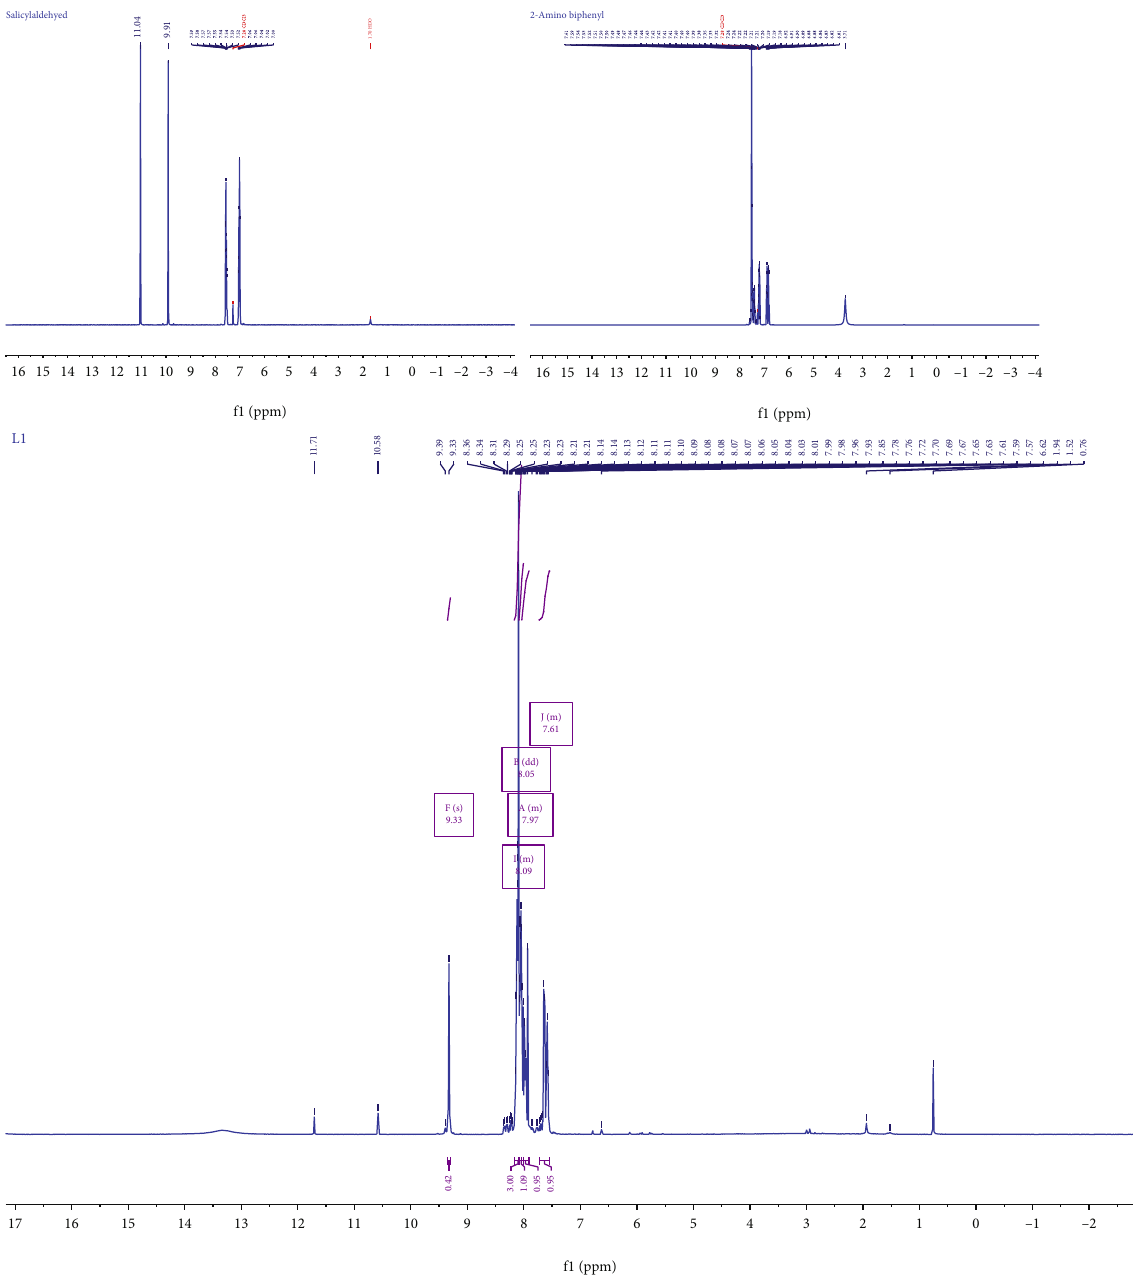
Figure 1: Comparison of magnetic resonance spectra nuclei of salicylic aldehyde, 2-aminobyphenyl, and ligand